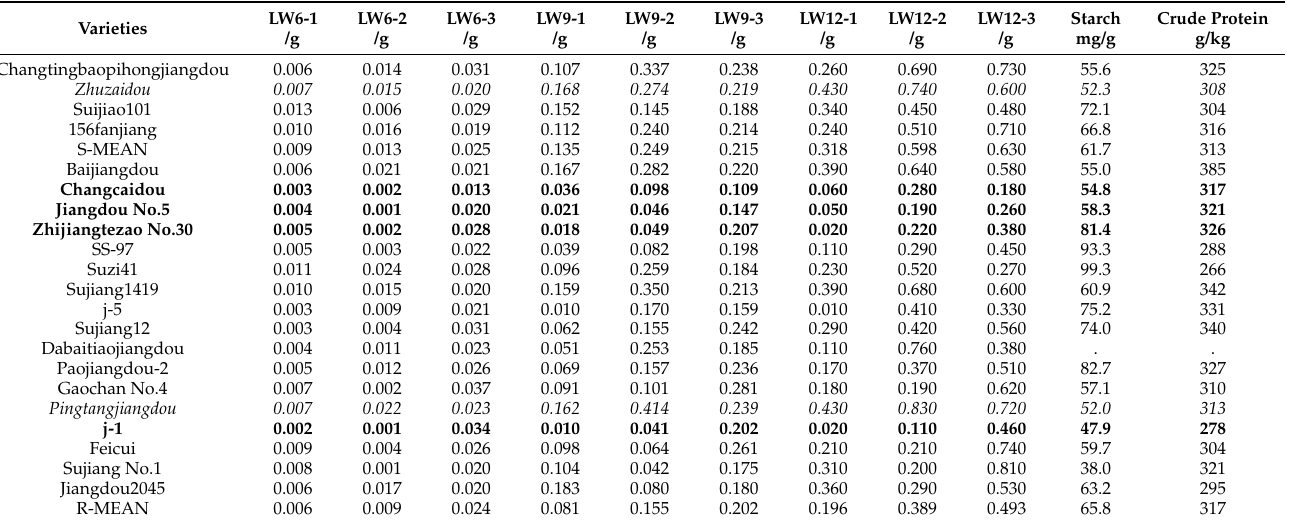
Table 5. The larval weight and leaf nutrient content of the preliminarily screened insect-resistant and insect-sensitive varieties in verification experiments.